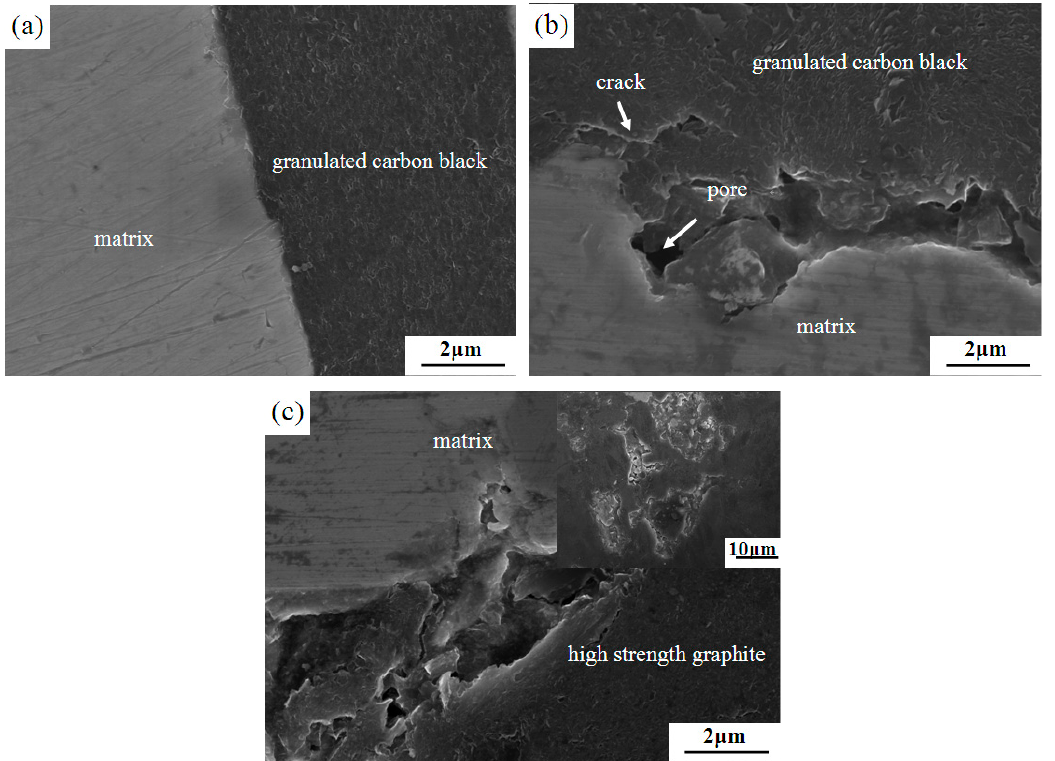
Figure 3. Interface microstructures with different lubricating phase: ( a ) 5% GCB; ( b ) 10% GCB, and ( c ) 5% HSG. 5%